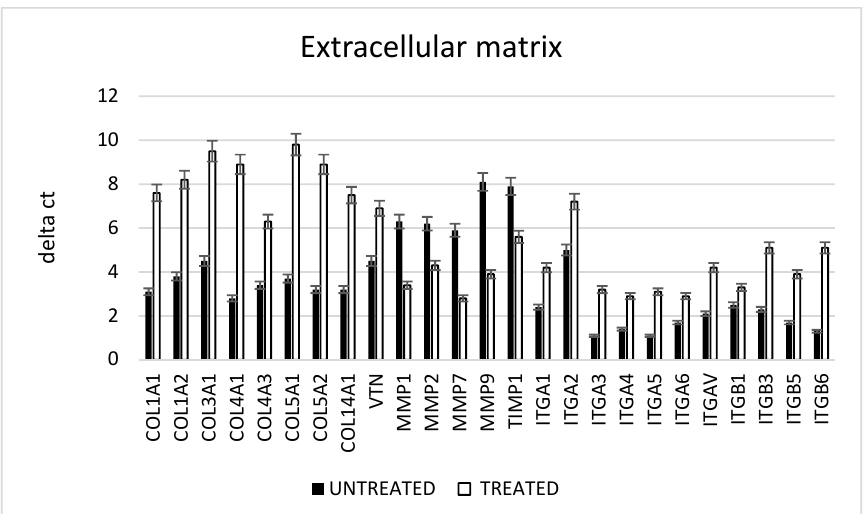
Figure 6. Gene expression related to collagen, remodeling enzyme and integrin expression. All the cells are cultured in the presence of an inflammatory condition; the black bars show normal conditions, the white bars show the presence of the CMF.